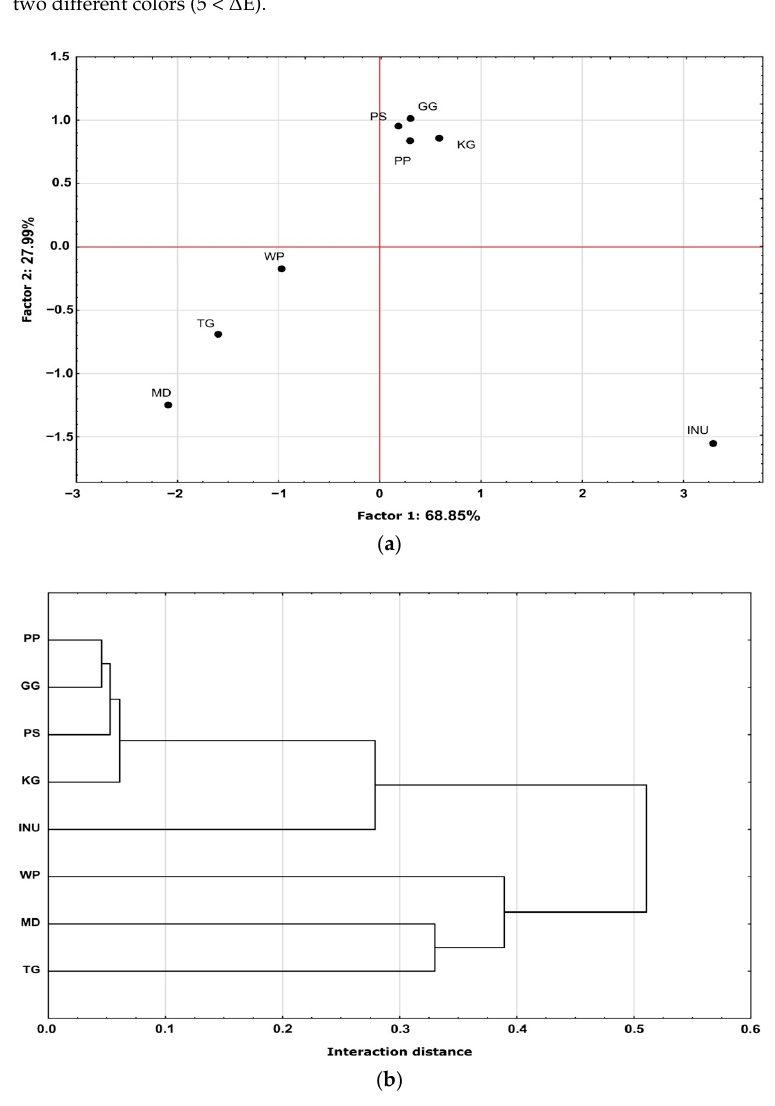
Figure 5. Principal component analysis PCA ( a ) and hierarchal cluster analysis HCA ( b ) of the analyzed biopolymers.